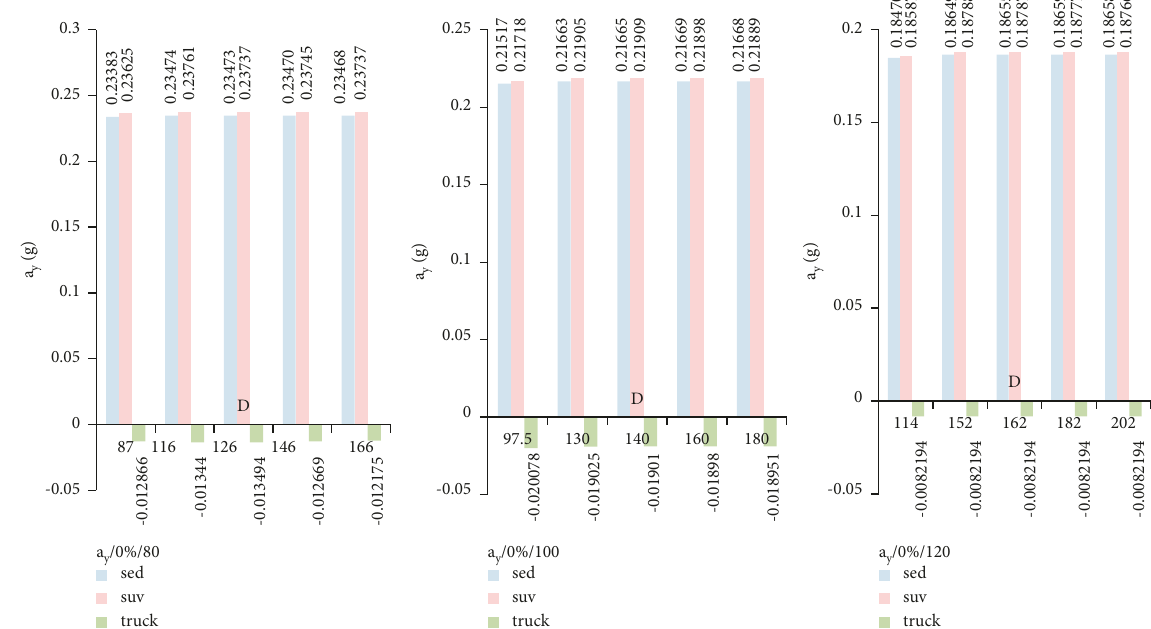
Figure 3: Lateral acceleration changes by changing the direct distance ( D ) in nonslope mode and speeds of 80, 100, and